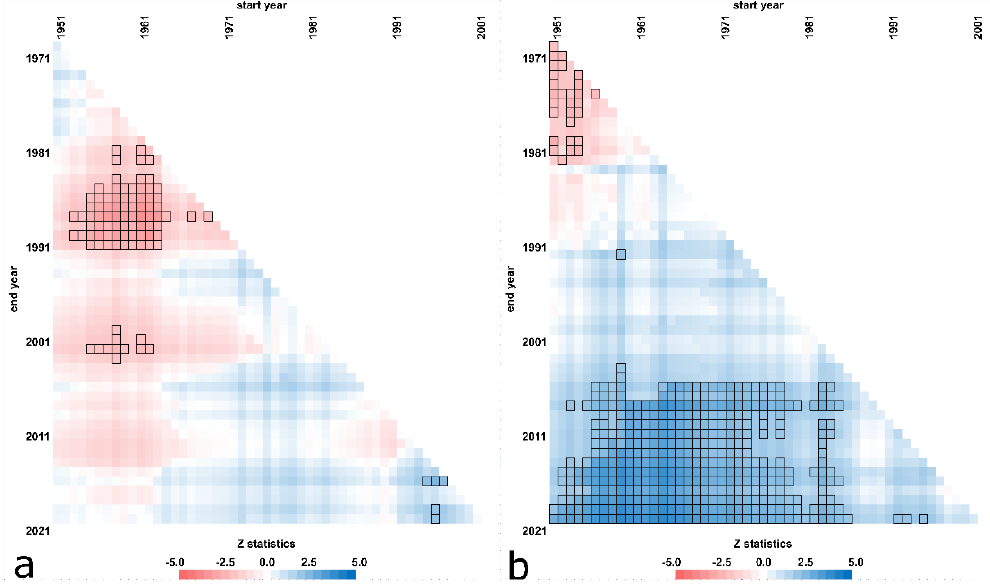
Figure 11. Multitemporal trend analysis of the time of flows below Q90% (TBQ90%) for the Gwda ( a ) and Flint ( b ) rivers (marked fields indicate statistically significant changes at the level 0.05). However, when it comes to the duration of flows in the range from Q90 to Q50%, the situation varies greatly between the studied rivers (Figures 12 and S5).